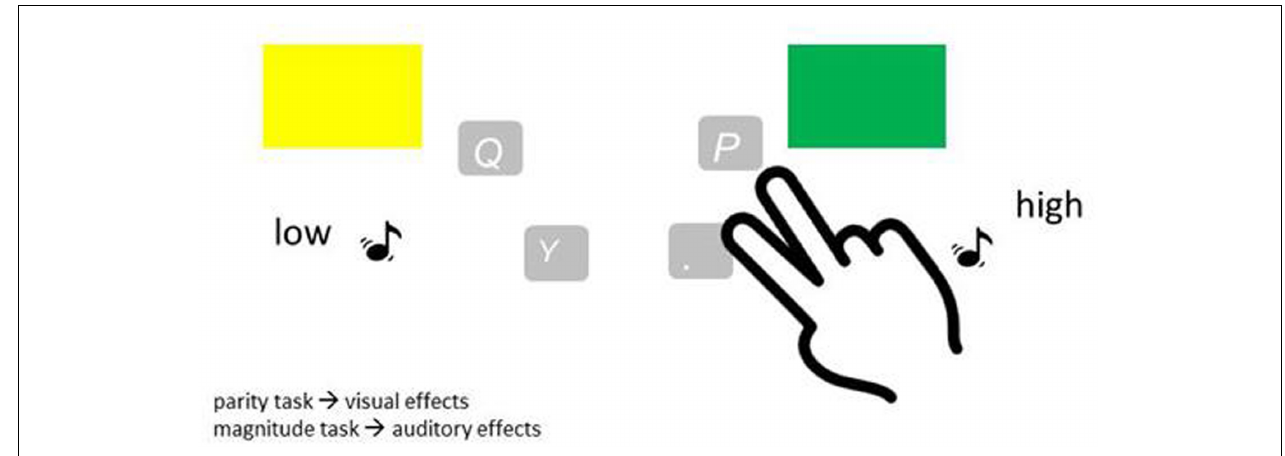
FIGURE 1 | Example of a task-effect assignment for the experimental groups. Performing one task (here: the parity task, which was executed with the response keys q and p) elicited visual action effects, the respective other task (here: the magnitude task, executed with the response keys y and period) auditory action effects.